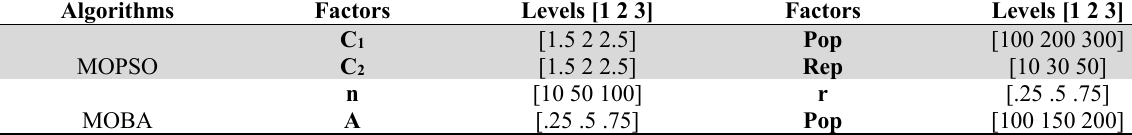
Parameter values and levels of MOPSO and MOBA (raw material inventory model)